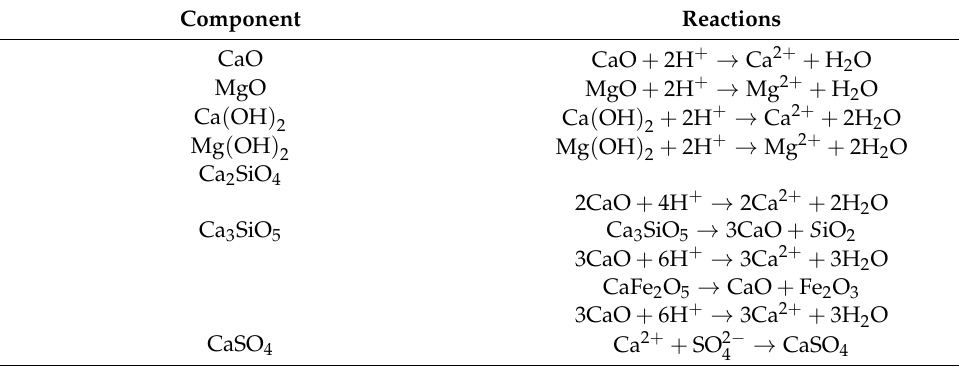
Table 2. Possible reactions occurred in the titration